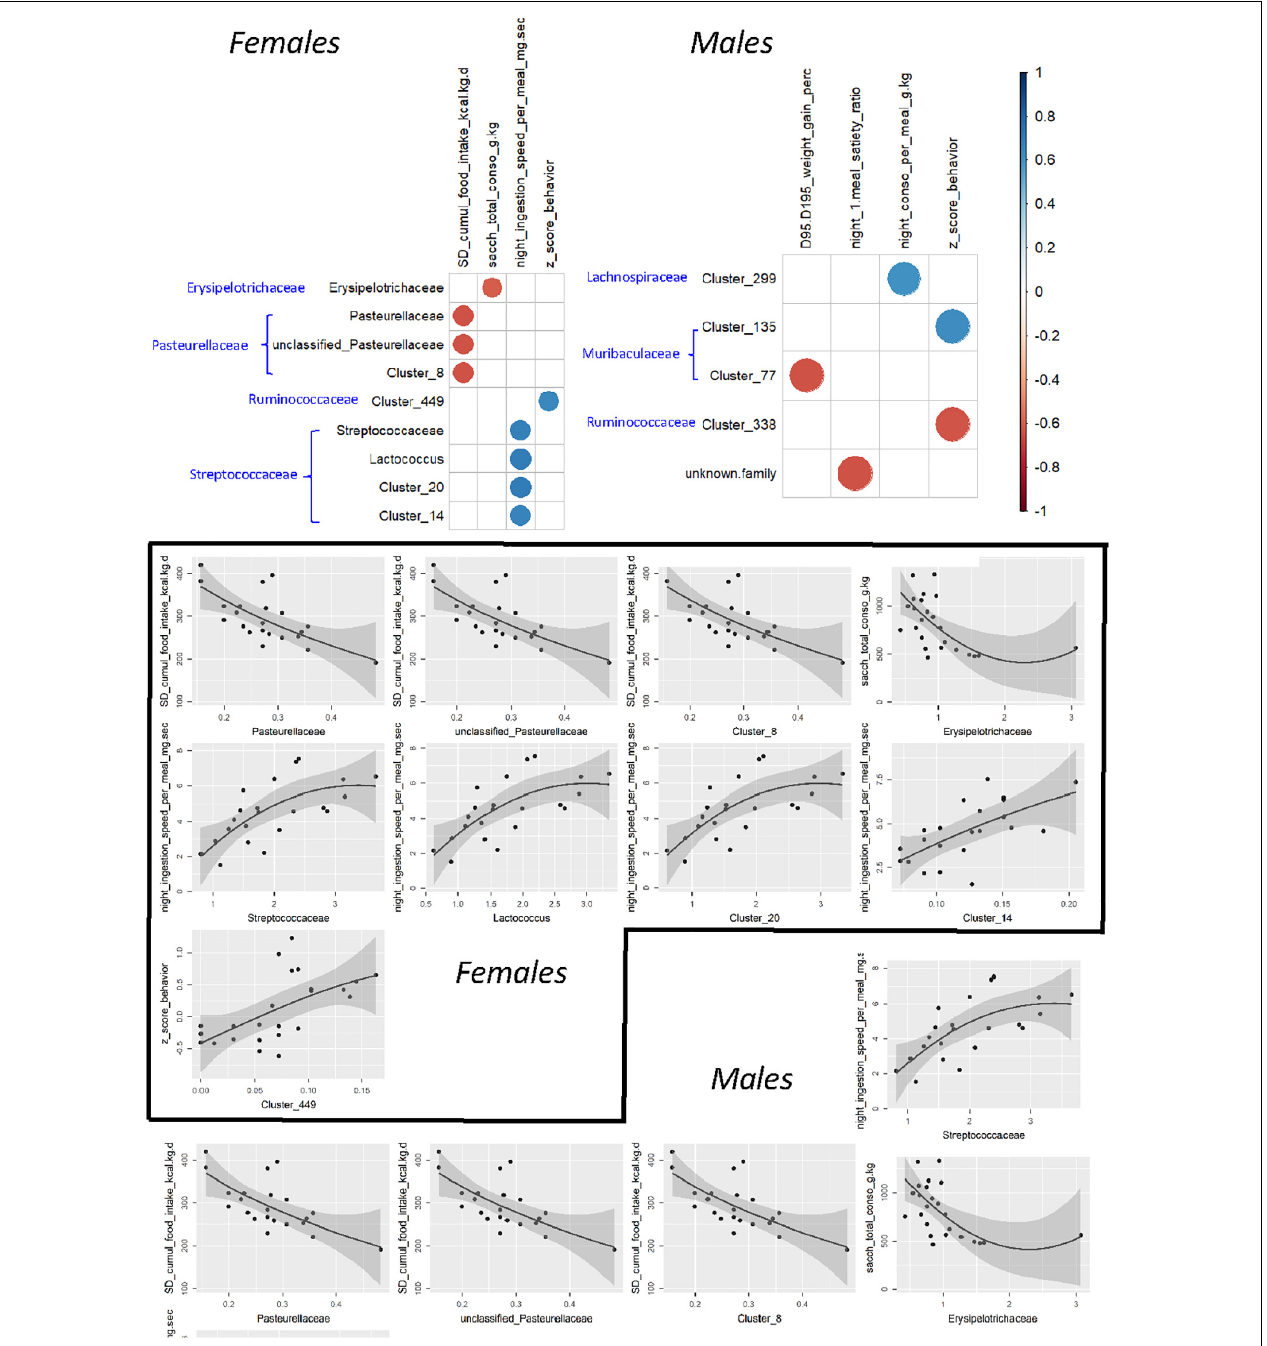
FIGURE 12 | Correlograms showing significant ( α < 0.01) Spearman rank correlations among selected components of eating behavior and the relative abundances of some bacterial taxa in F344 recipients and corresponding scatter plots, using individual data from PND200 female and male animals. In all correlograms, positive correlations are displayed in blue and negative correlations in red as scaled on the right. The black line and associated gray zone represent a LOESS smoother and the 95% confidence interval,